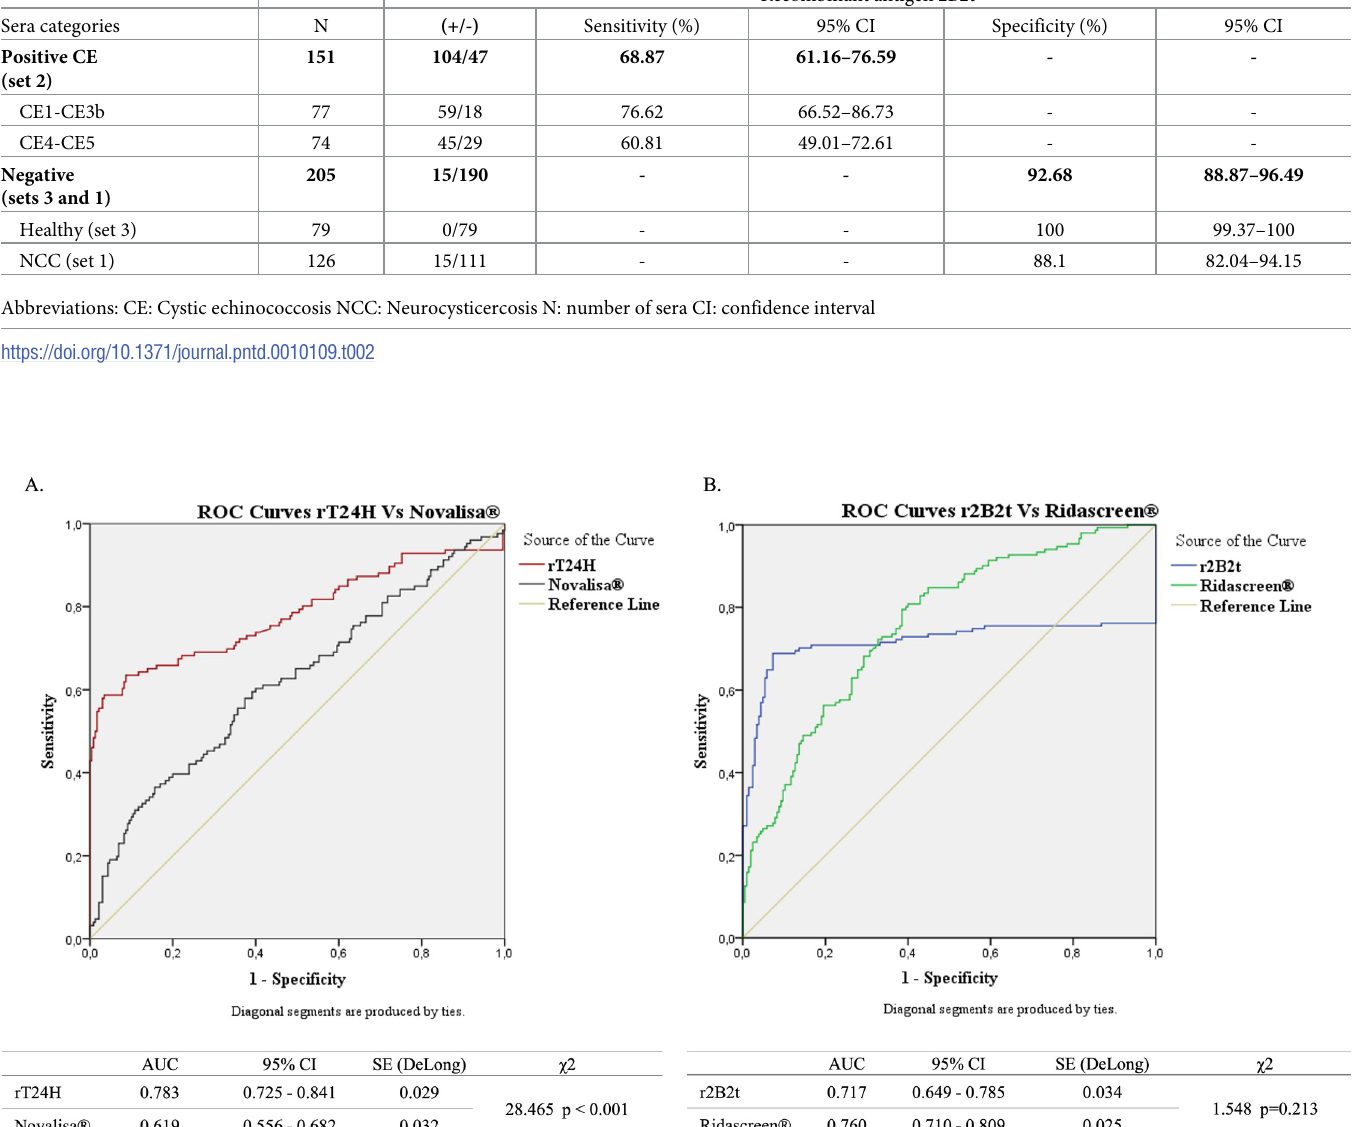
PLOS NeglectedTropical Diseases | https://doi.org/10.1371/journal.pntd.0010109 January 14,